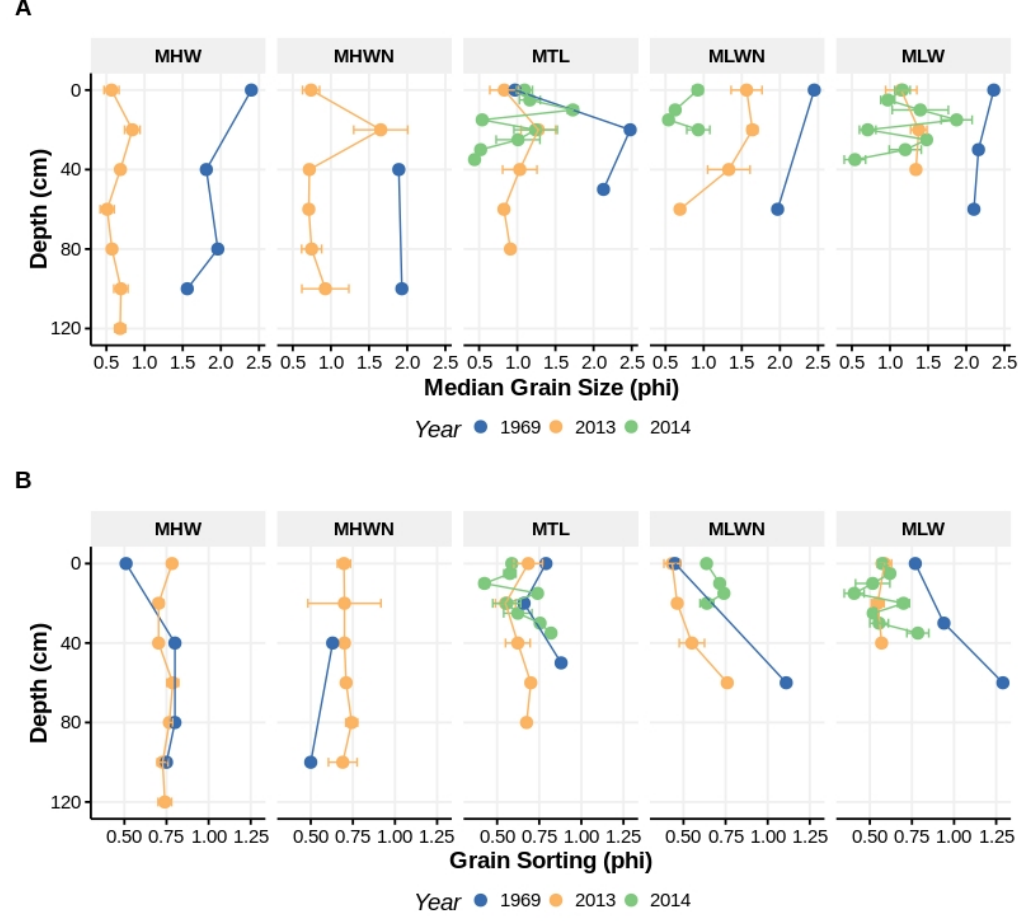
Figure 4. Comparison of median grain size ( A ) and sorting ( B ), both measured in phi, from the beach surface to depth at several intertidal heights at Iron Steamer Pier Beach. The historical data (blue) are from Lindgren (1972). The 2013 and 2014 (yellow and green, respectively) data, collected from the same location as the Lindgren data, are means and have standard errors associated with them. Tidal heights: MHW = mean high water; MHWN = mean high water neap; MTL = mean tidal level, MLWN = mean low water neap; and MLW = mean low water.